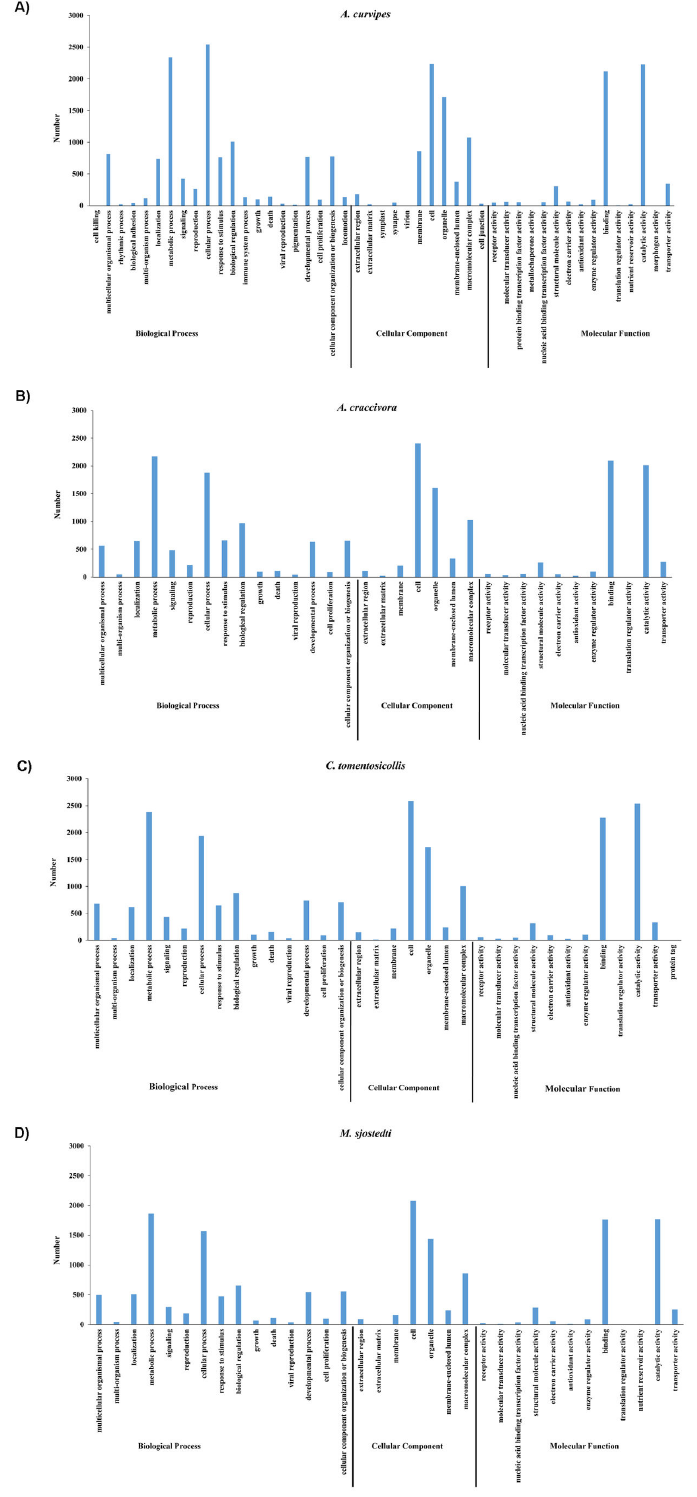
Figure 2. Gene ontology classification into biological process, cellular component and molecular function. Gene ontology terms were determined using an e-value of ≤ 1.0 e-6 sorted based on level 2 classifications in all the contigs of (a) A. curvipes , (b) A. craccivora , (c) C. tomentosicollis , (d) M. sjostedti . doi: 10.1371/journal.pone.0079929.g002 PLOS ONE |